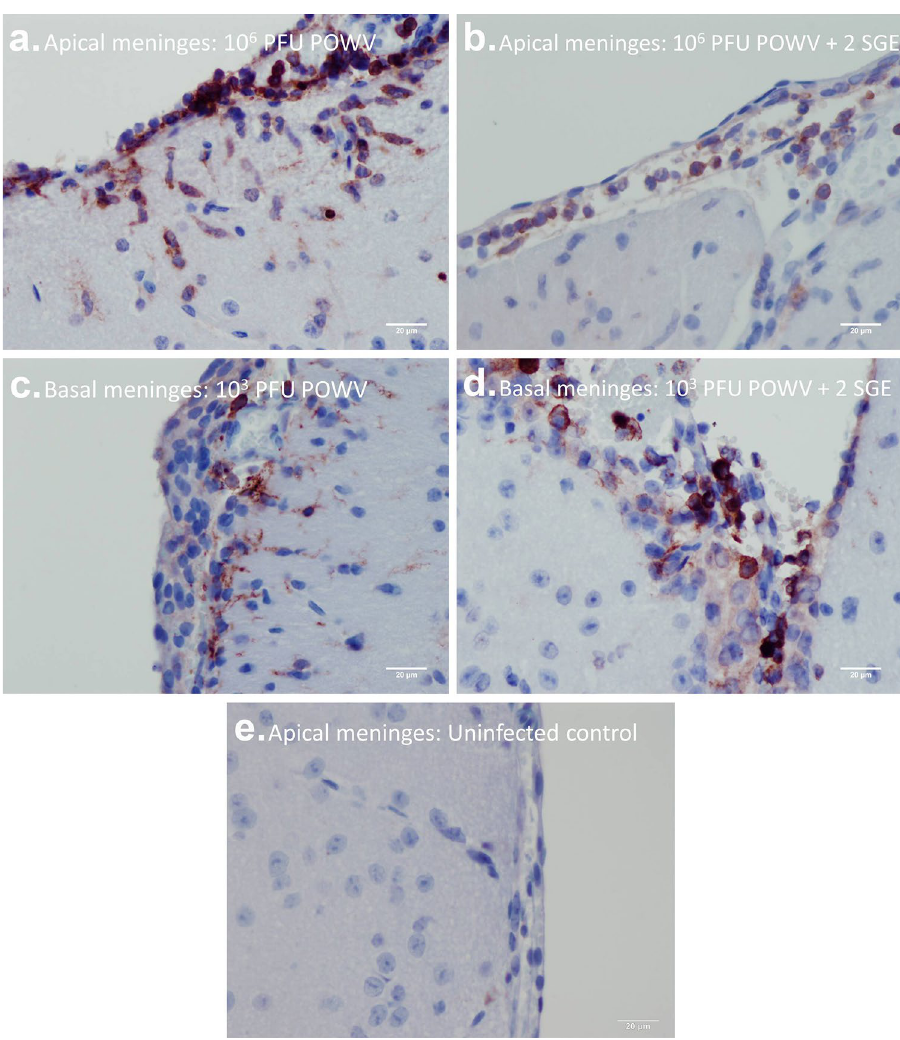
10 6 PFU POWV + 2 SGE, apical meninges. ( c ) 10 3 PFU POWV, basal meninges. ( d ) 10 3 PFU POWV + 2 SGE, basal meninges. ( e ) Uninfected control, apical meninges. Scale bars represent 20